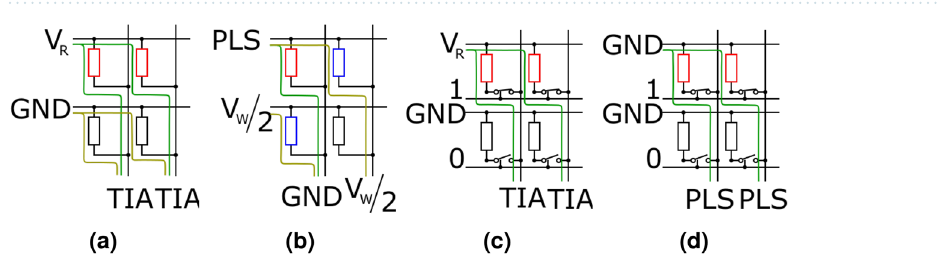
Figure 10. Basic read ( a ) and write ( b ) operations for selectorless crossbar arrays. ( c ) and ( d ) show the same operations for selector enabled arrays. Red, blue and black devices correspond to selected, half-selected and unselected devices. Intended current paths are shown in green, sneak paths shown in